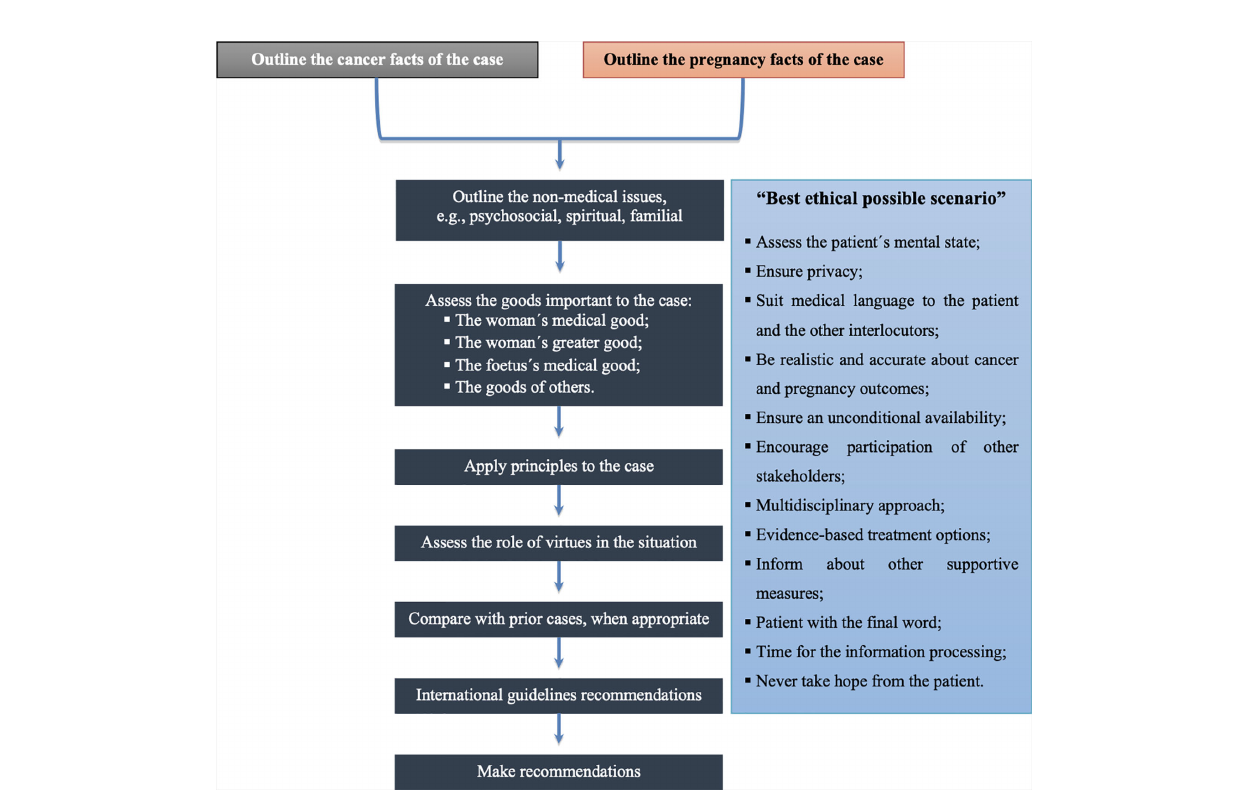
FIGURE 2 | Algorithm for biomedical ethical decision-making (adapted from Schenck (38) and Botha et al.